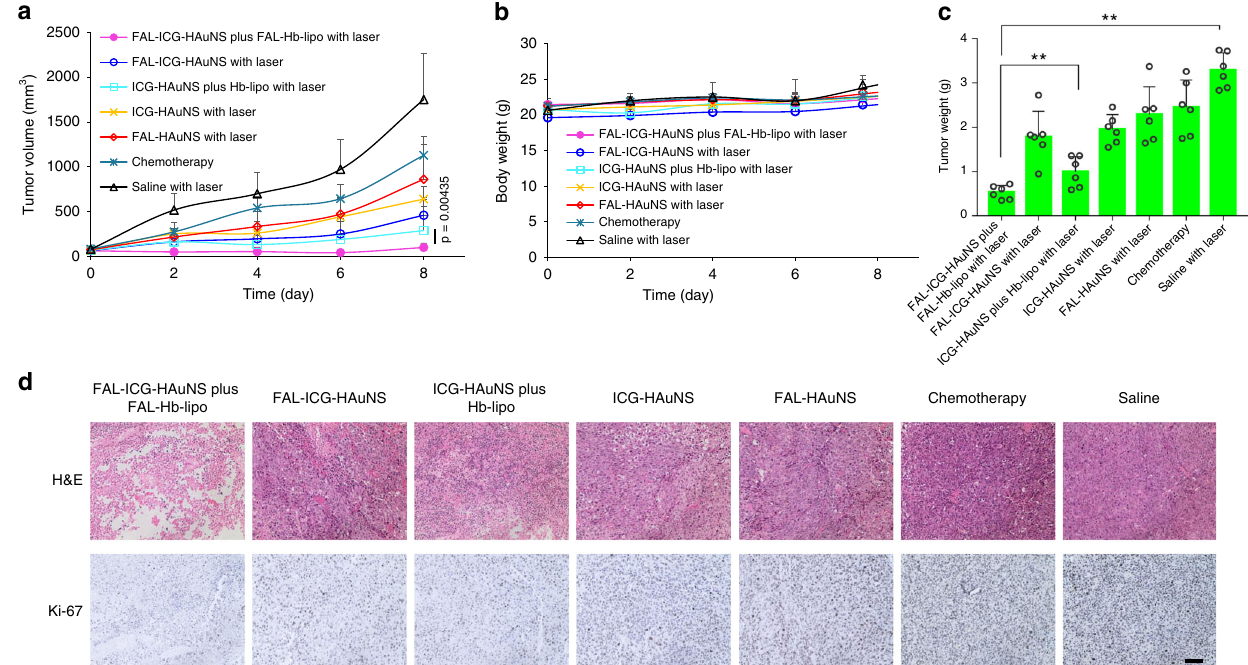
Fig. 8 Antitumor ef fi cacy in B16 tumor model. a Growth curves of B16 tumors after treatment with saline, chemotherapy (Taxotere: 10 mg/kg per injection), FAL-HAuNS, ICG-HAuNS, FAL-ICG-HAuNS, ICG-HAuNS plus Hb-lipo, or FAL-ICG-HAuNS plus FAL-Hb-lipo (ICG: 0.5 mg/kg, HAuNS: 1 mg/kg, Hb: 20 mg/kg per injection). Taxotere, ICG-HAuNS, or FAL-ICG-HAuNS were injected on days 0, 2, and 4. Hb-lipo and FAL-Hb-lipo were injected on days 1, 3, and 5. Tumors (except the chemotherapy group) were exposed to laser irradiation (1 W/cm 2 , 2 min) on days 1, 3, and 5. n = 6. b Body weight change curves, n = 6. c Average tumor weights in different groups at the end of treatment. d Representative hematoxylin and eosin and Ki-67 staining photographs in each group. Scale bars, 100 μ m. All data were analyzed with one-way analysis of variance test (* P ≤ 0.05; ** P ≤ 0.01). All error bars are expressed as Hb-lipo group. In addition, in fi ltration of CD3 + T cells in tumor antitumor immune activity. Furthermore, the amount of immu- tissue elevated to 36.5% (Supplementary Fig. 15). The levels of nosuppressive cells such as Treg cells (Foxp3 + cells) decreased in the ER-targeting PDT/PTT groups. The treatments induced an CD8 + T cells, IFN- γ , and Foxp3 + cells in tumors were further obvious increase in cytotoxic cytokine (TNF- α and IFN- γ ) levels evaluated with immuno fl uorescent staining (Fig. 9a). Enhanced fl uorescent intensity of CD8 + and IFN- γ indicated a strong in tumor tissues (Fig. 9d). In order to investigate populations of